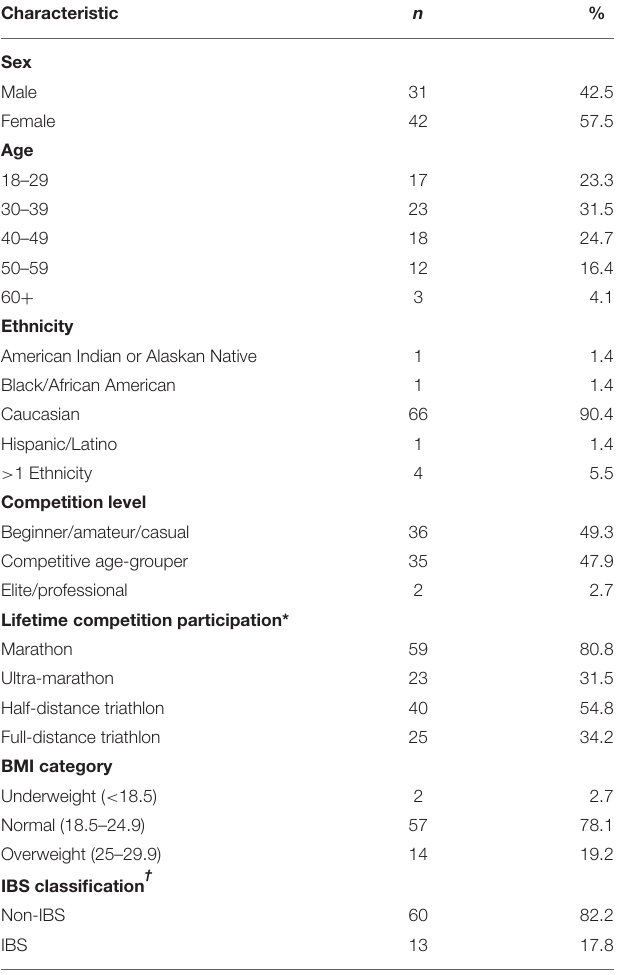
TABLE 1 | Comprehensive nutrition assessment questionnaire (CNAQ) endurance athlete participant demographics ( n =